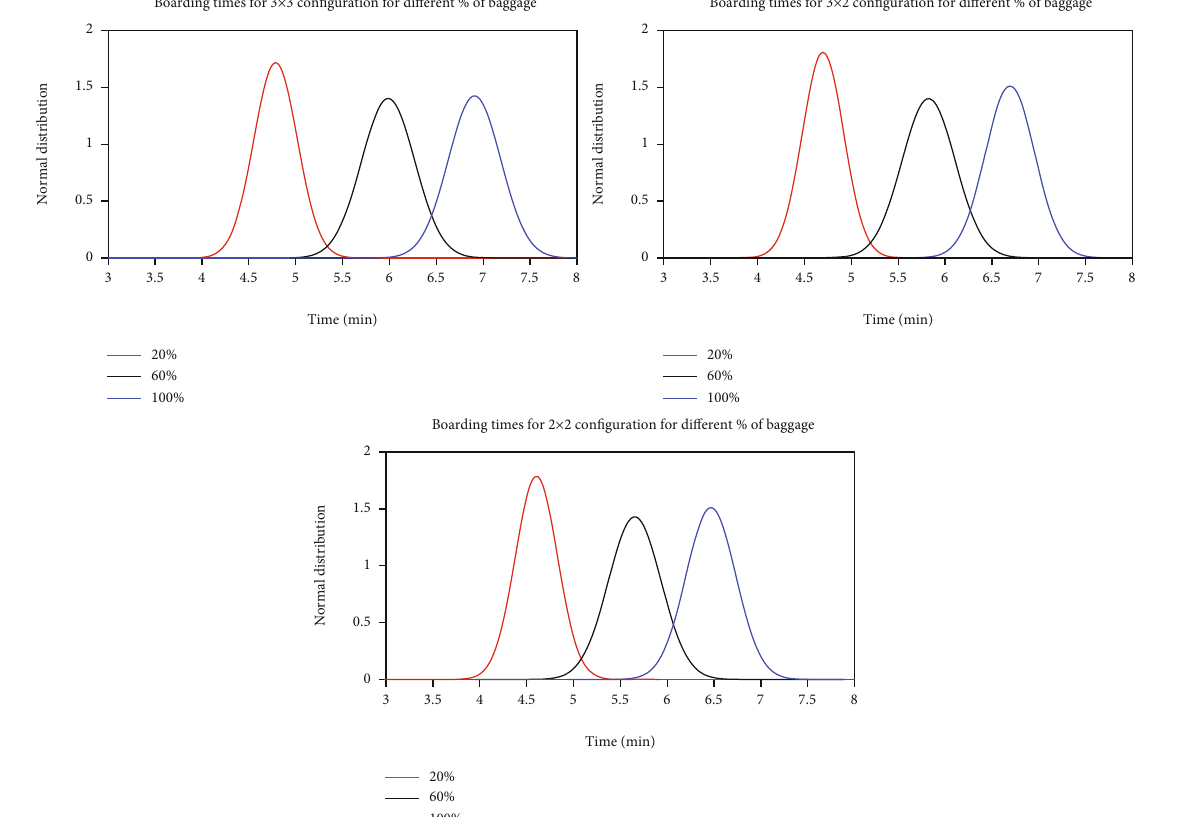
Figure 13: Fitted normal distribution curves for the three aircraft con fi gurations using the random outside-in boarding strategy for di ff erent % of baggage.